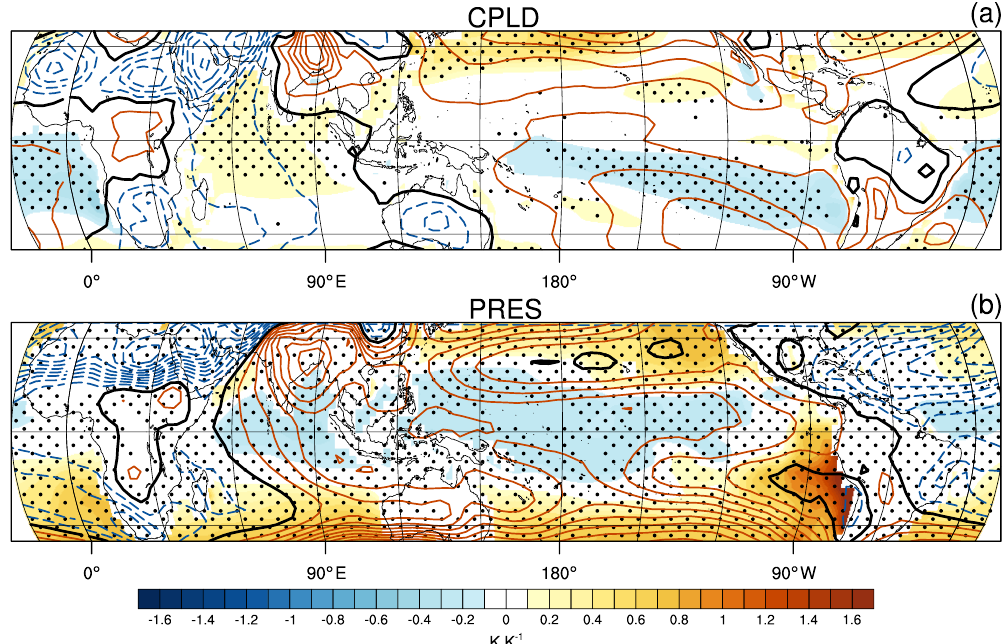
Figure 4. As Fig. 1, except showing the dSST ∗ response (shading) and SLP response (contours, interval 0.2hPaK − 1 with blue as negative, red as positive, and black denoting the zero line). Stippling as in Fig.